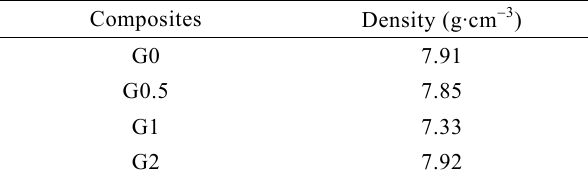
Fig. 2 XRD patterns of the composites. Table 2 Density of the composites.